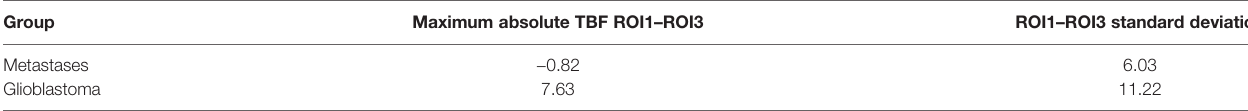
TABLE 3 | Mean values of peritumoral blood fl ow gradient (ROI1 – ROI3) for metastases and glioblastomas. Group